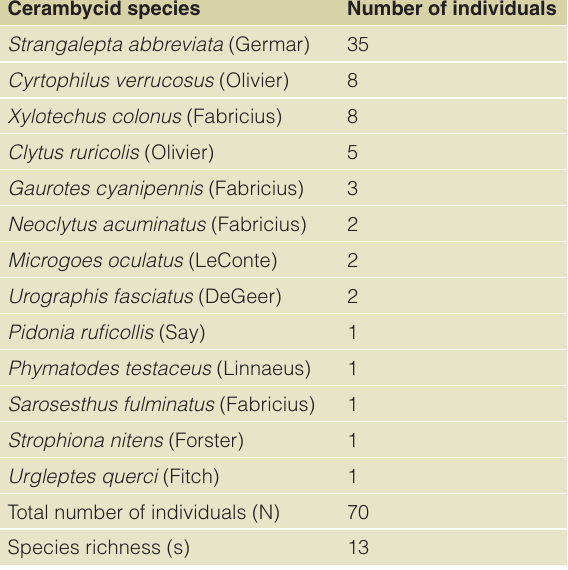
Table 1. Cerambycid (Coleoptera: Cerambycidae) Species Captured in Oak Openings Preserve, 2008 (Western Lucas County, OH). Total number of individuals of each species caught during the entire trapping period (early June to early October). Traps were positioned in the approximate center of each forest and all checked each week.